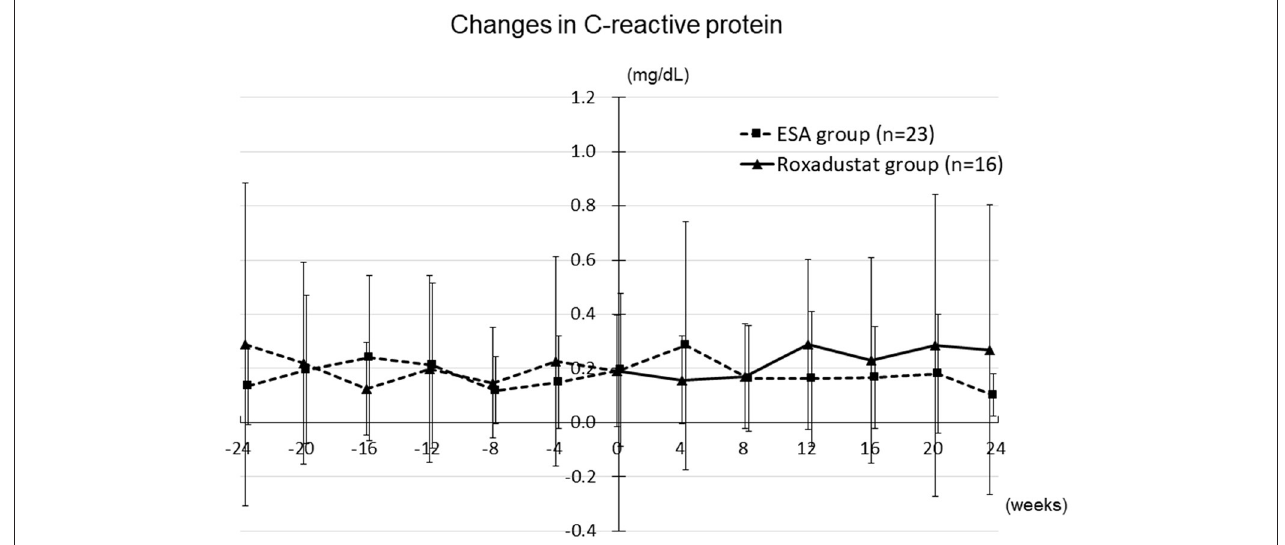
FIGURE 11 | Changes in the C-reactive protein concentration in the Roxadustat and ESA groups. ESA, erythropoiesis-stimulating